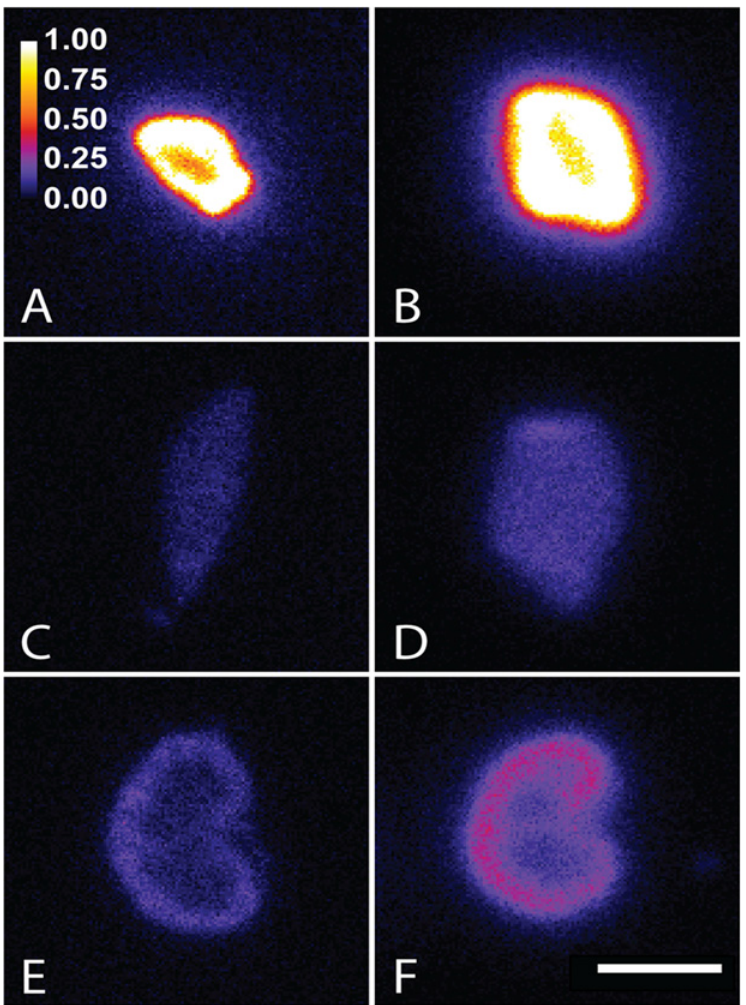
Fig 2. Autoradiographs acquired using the novel iQID camera. Panels show the distribution of 177 Lu (A, C, and E) and 90 Y (B, D, and F) 24 hours after injection of labeled DOTA-biotin in 1F5-SA-pretargeted tumor (A and B), liver (C and D), and kidney (E and F) cryosections. The scales apply to all panels; the color bar represents relative pixel intensity normalized to the mean for the tumor sections and the white scale bar indicates 5